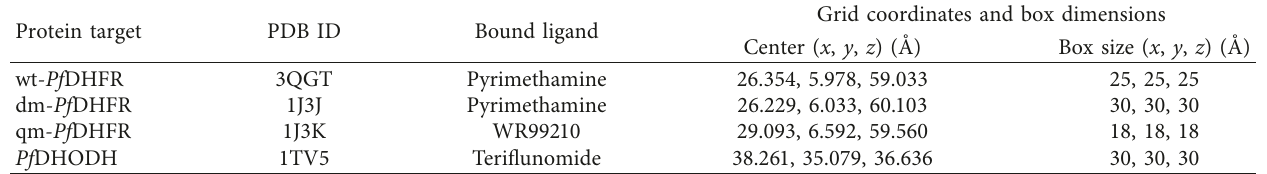
Table 1: Protein targets and grid dimensions used in protein-ligand